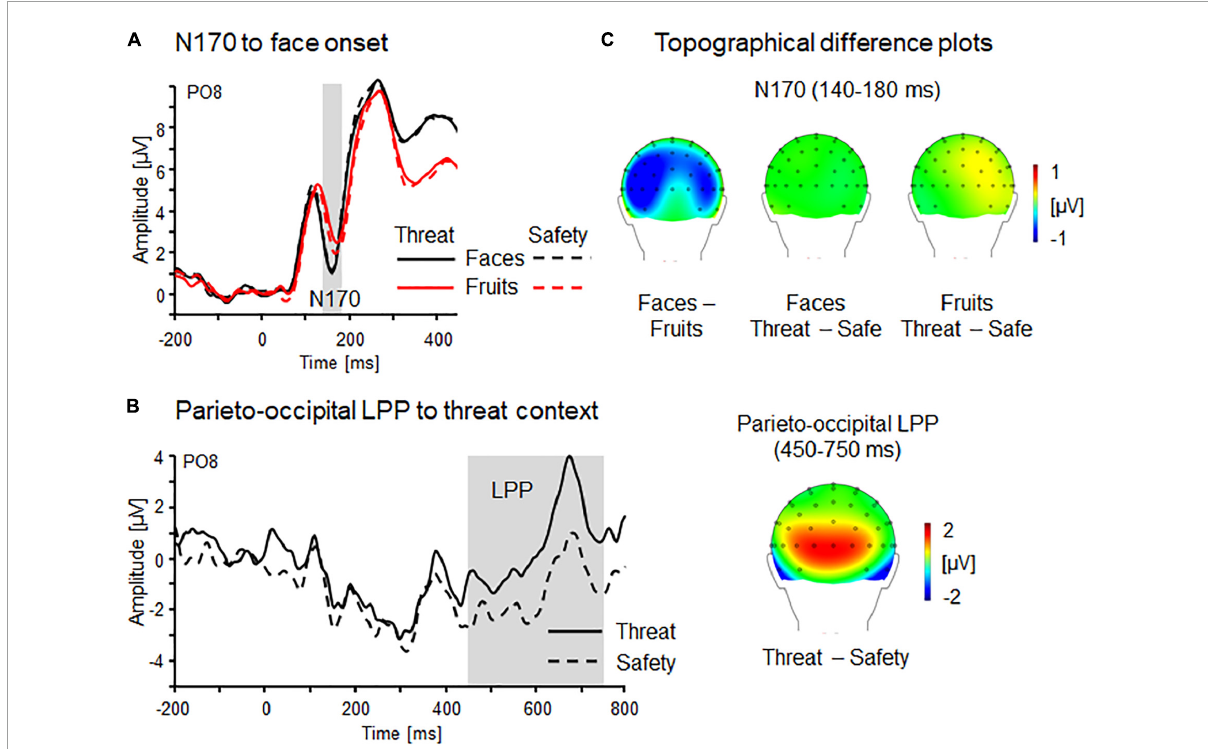
FIGURE3 Face and context processing indicated by N170 and LPP components confirm experimental manipulation. (A) Event-related brain potential waveforms as a function of stimulus onset (faces, fruits) and context (threat, safety) as revealed by parieto-occipital N170 component (PO8) and (B) Parieto-occipital LPP effects linked to the onset of contextual threat and safety. (C) Topographical difference plots (faces–fruits and threat–safety for faces and fruits) displaying N170 stimulus effects, and LPP effects linked to the onset of contextual threat or safety. Waveform differences are displayed on the back view of a model